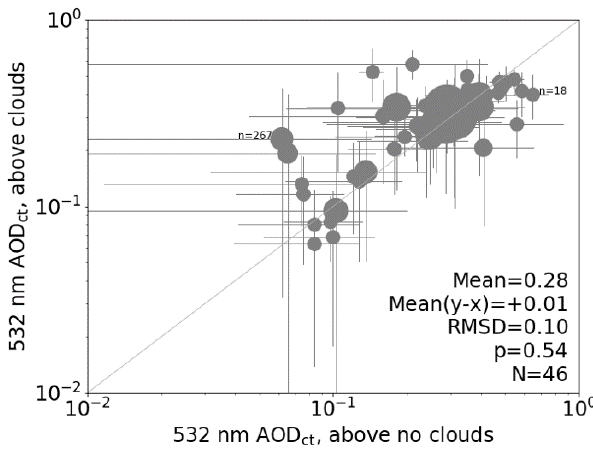
Figure 4. The mesoscale monthly-mean samples of the AOD above cloud top height. Each marker represents the mean over a box shown in Fig. 2. The bar represents the ± 1 standard deviation range. The marker size is proportional to the number ( n ) of 10s measure- ments, the fewer of the cloudy and clear groups, for each combi- nation of box and month. N refers to the number of monthly box means with n ≥ 10 in both cloudy and clear